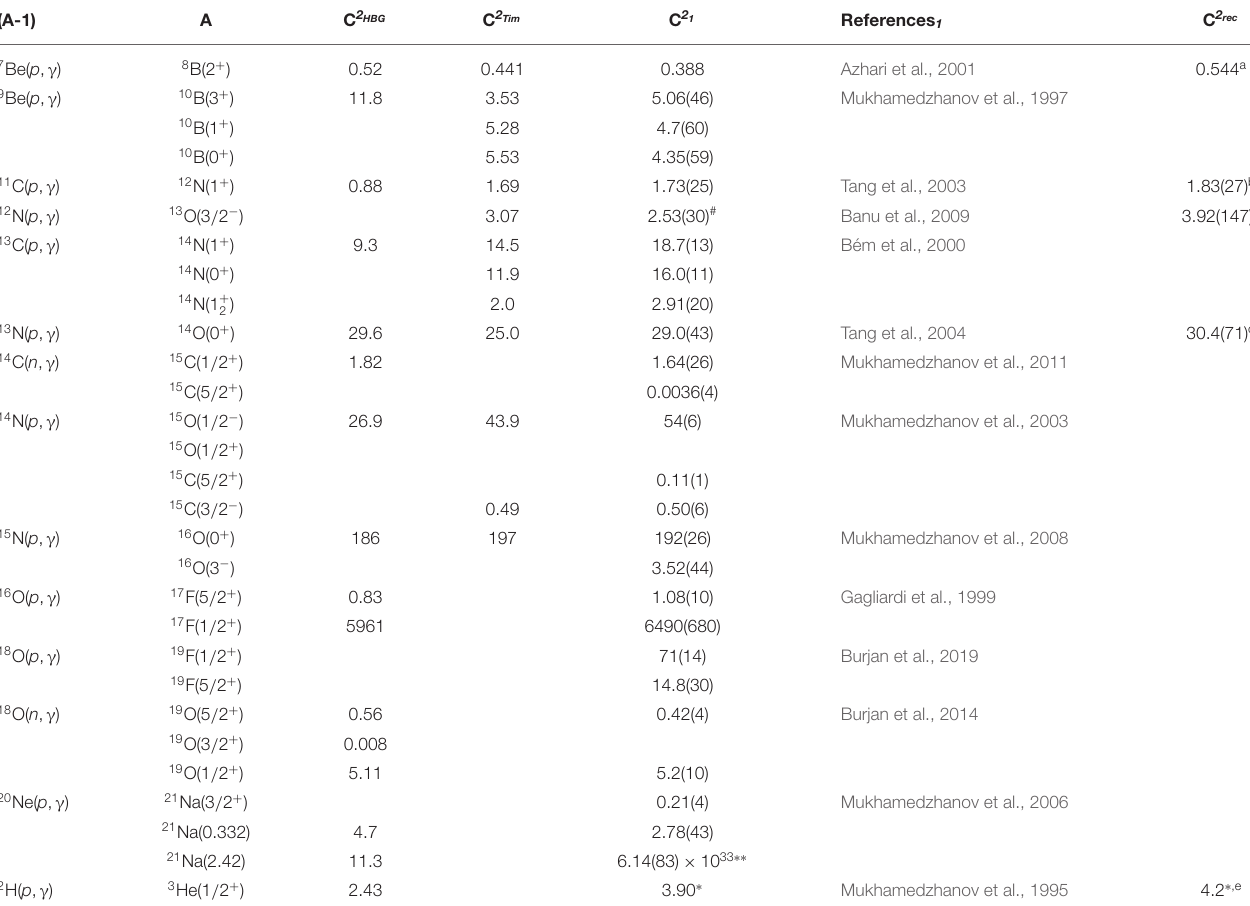
TABLE 2 | Squared ANC values (in units of [fm − 1 ]) for selected reactions discussed in this paper (column C 2 1